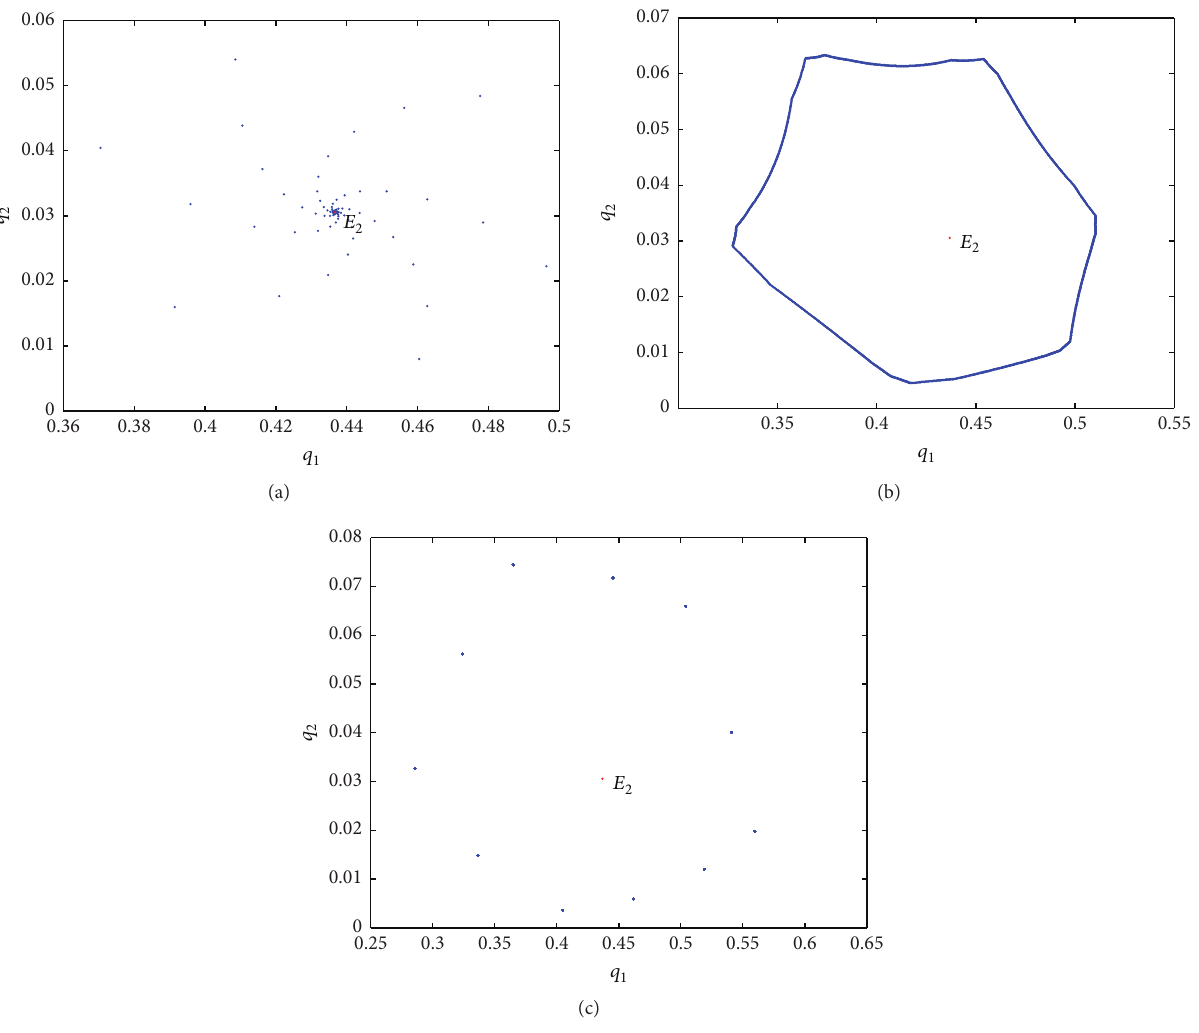
= 0.48, V = 0.7, 𝑐 = 0.14, 𝑐 = 2 . 1 2 1 2